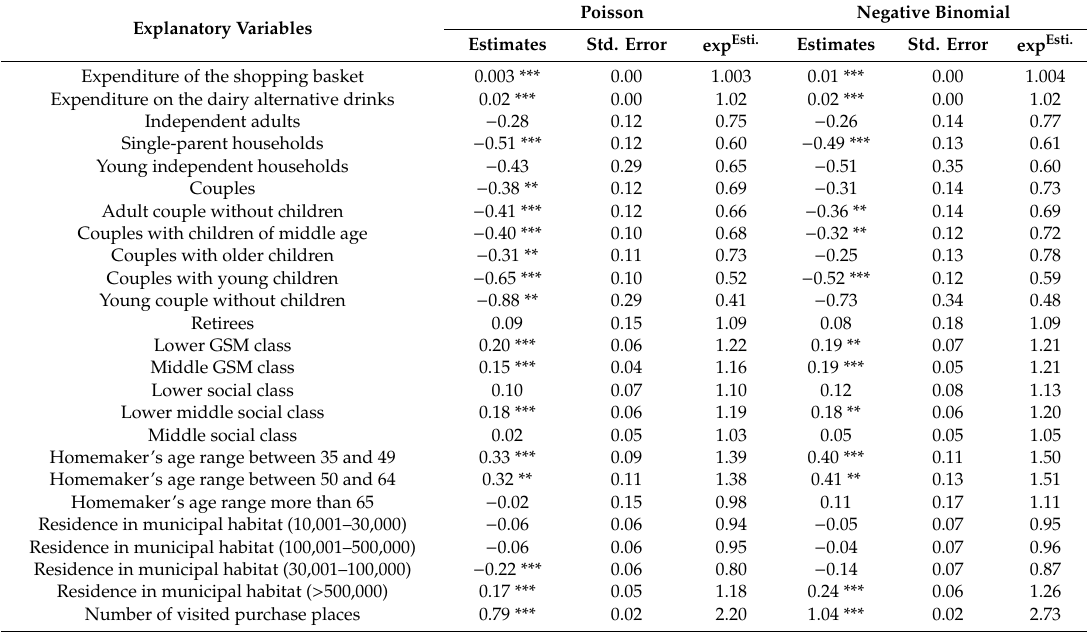
Table 3. Poisson and negative binomial regressions estimates.